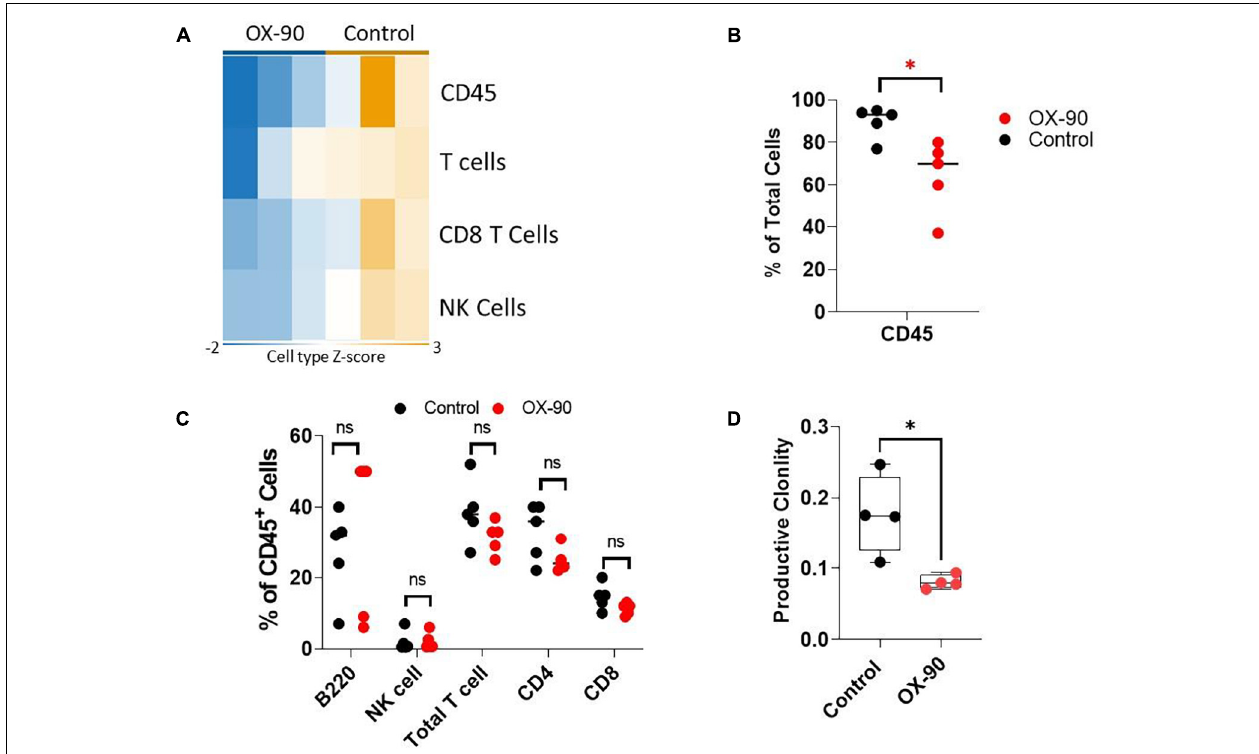
FIGURE 5 | CD200 blockade alters tumor immune microenvironment. (A) Nanostring analysis of tumors ( n = 3/group) from OX-90 or vehicle treated mice was performed using total tumor RNA and the Nanostring Pan cancer IO 360 panel, and results were analyzed using Rosalind software. Heat map showing cell type abundance in tumors are presented. (B,C) Flow cytometry analyses of subtypes of tumor infiltrating leukocytes. Percent of positive cells from each group was calculated relative to total tumor cells (B) or total CD45 + cells (C) . ∗ P = 0.016 by two-sided Student’s t -test. ns: not significant. (D) Productive clonality of tumor infiltrating T cells. TCR-seq was performed on genomic DNA samples ( n = 4/group) from tumors grown in OX-90 or vehicle treated mice. Results were analyzed using ImmunoSEQ software. ∗ P = 0.0154 by two-sided Student’s t